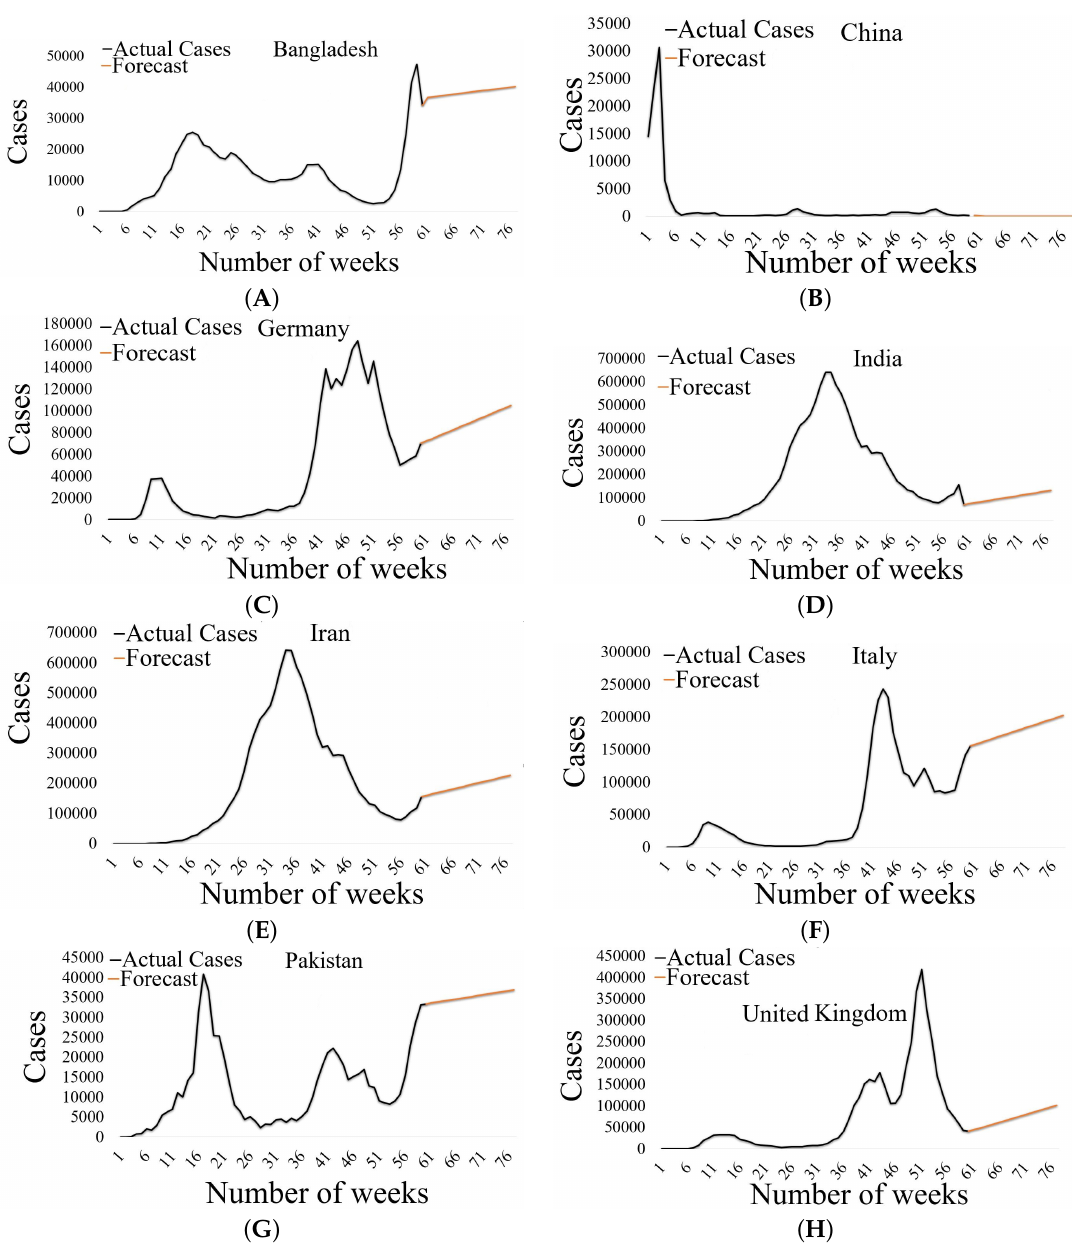
Figure 4. Actual cases in 60 weeks and predicted cases in future weeks. Figure 5 shows a detailed view of the total number of weeks on the x-axis and the number of actual deaths and predicted deaths on the y-axis. Graph (A) shows the data from Bangladesh, graph (B) from China, graph (C) from Germany, graph (D) from India, graph (E) from Iran, graph (F) from Italy, graph (G) from Pakistan, and graph (H) shows the data from the United